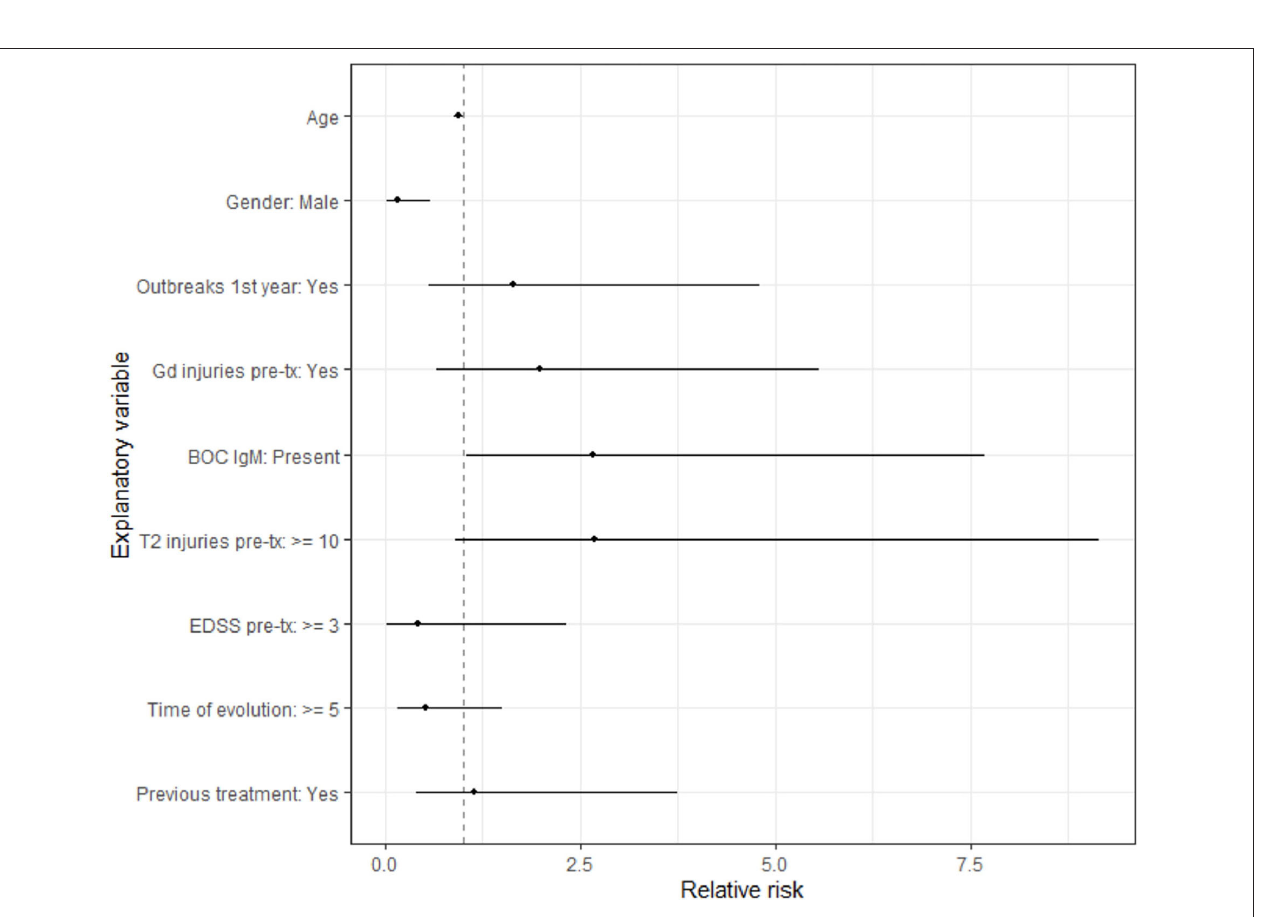
FIGURE 5 | Relapses relative risk according to patient